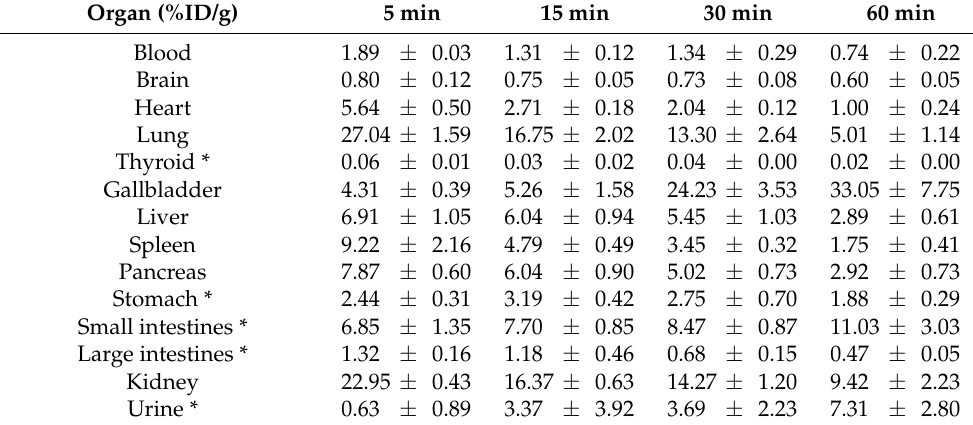
Table 1. Biological distribution of 125 I-ODV and metabolite of 125 I-ODV (control). Organ (%ID/g)